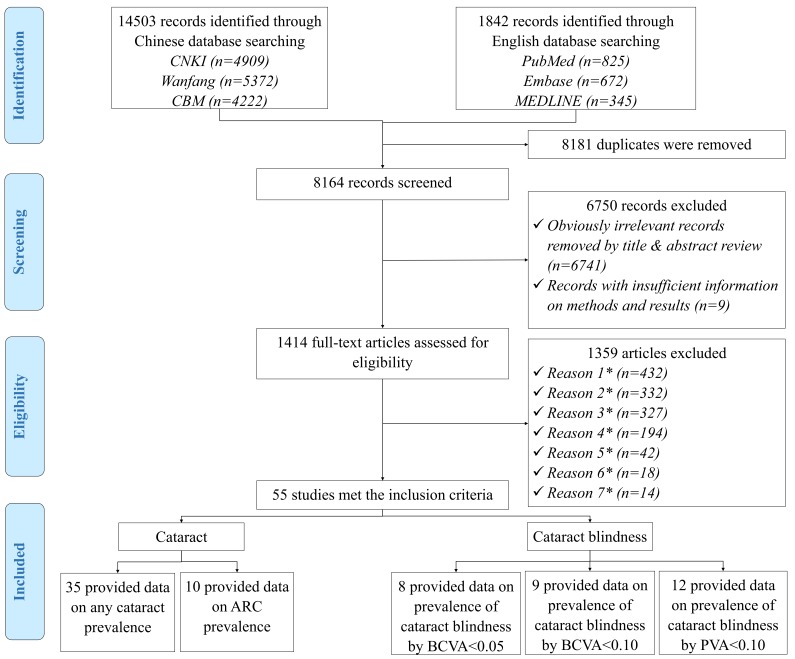
Systematic review flow diagram of studies on cataract and cataract blindness prevalence in China. *Reason 1 – Studies that were conducted in a population with unrepresentative characteristics (hypertensive patients, people with reduced vision, etc.); *Reason 2 – Studies that were not population-based; *Reason 3 – Studies that relied on self-reported diagnoses of cataract or cataract blindness; *Reason 4 – Papers with no numerical prevalence measure of cataract or cataract blindness; *Reason 5 – Studies that didn’t adopt the standardized definitions of cataract and cataract blindness; *Reason 6 – M ultiple publications of the same study; *Reason 7 – Studies that were not based in China.